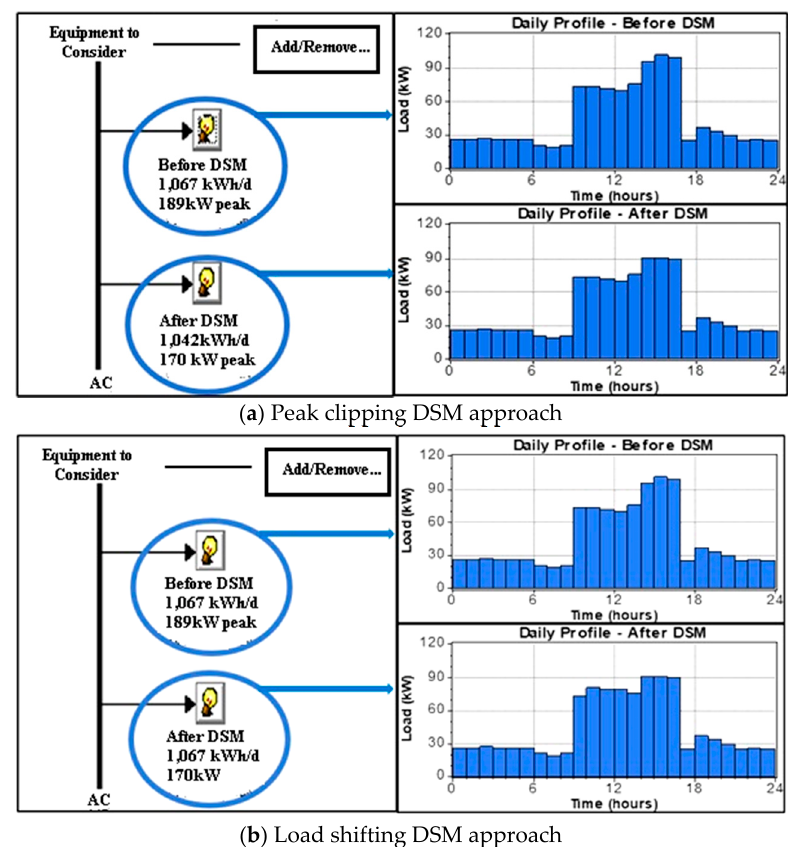
Figure 6. Daily Load Profile before and after DSM using HOMER.